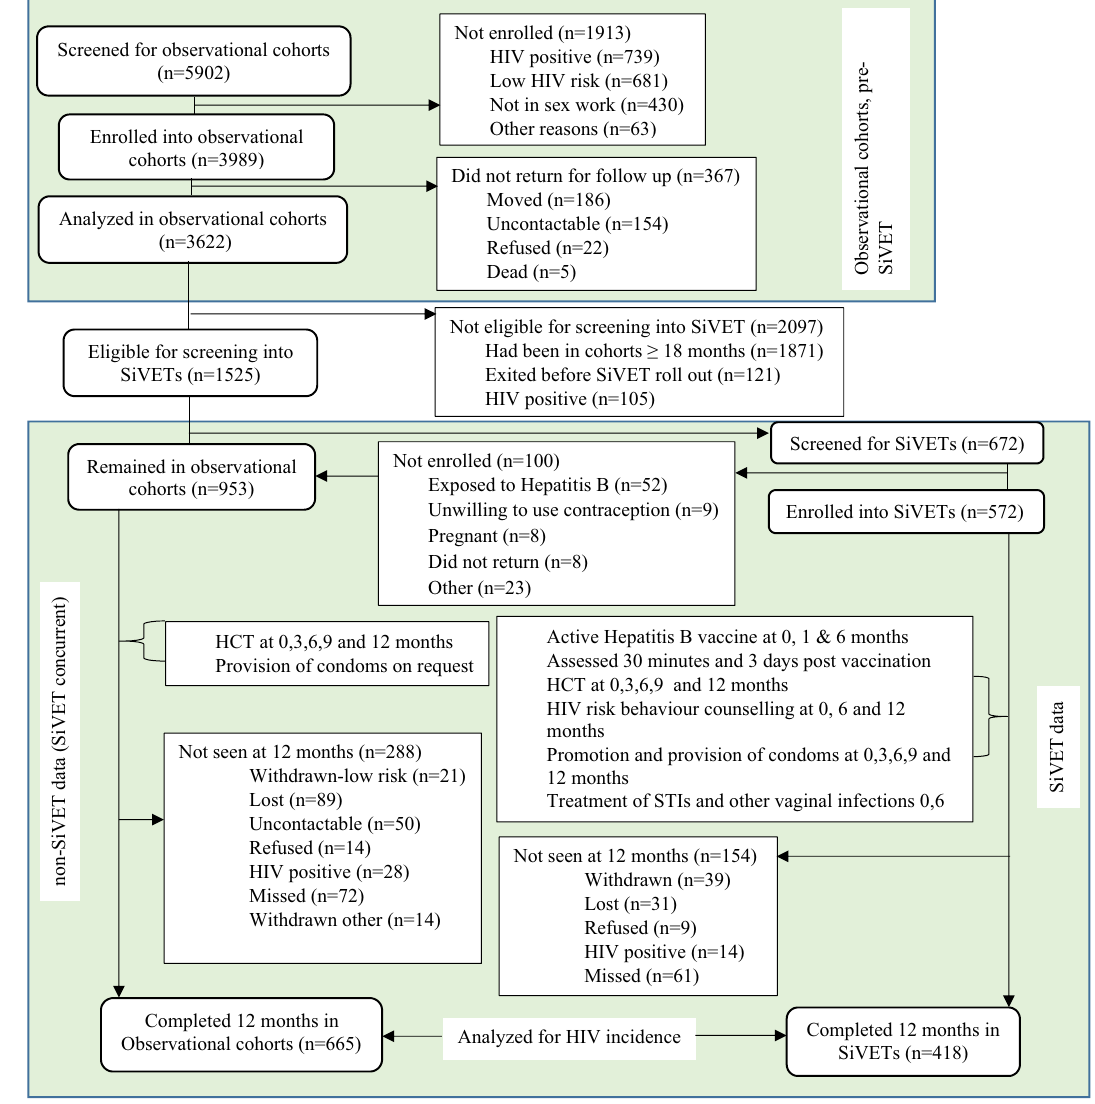
Figure 2. Study profile for participants screened and enrolled Pre and during SiVET in two key populations in